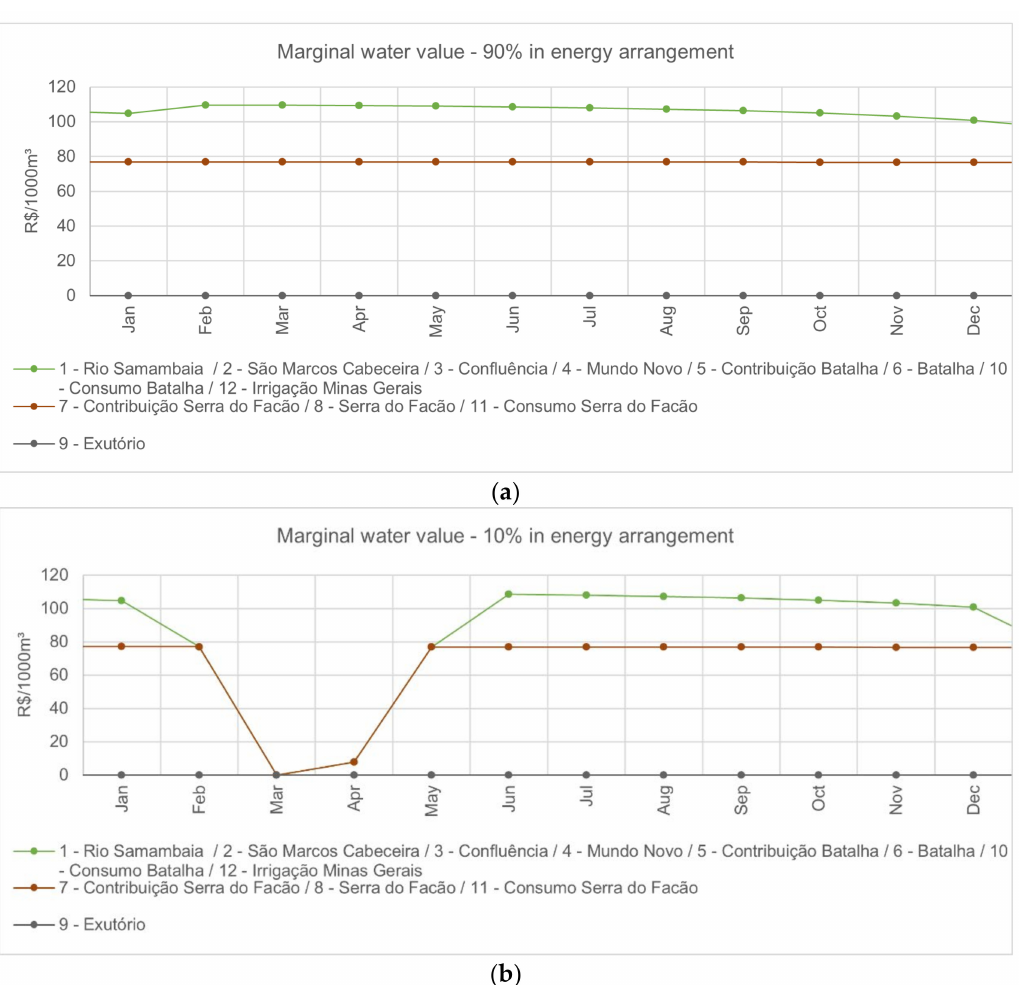
Figure 9. Marginal value of water in the nodes per month, energy arrangement, with 90% ( a ) and 10% ( b ) exceedance prob-